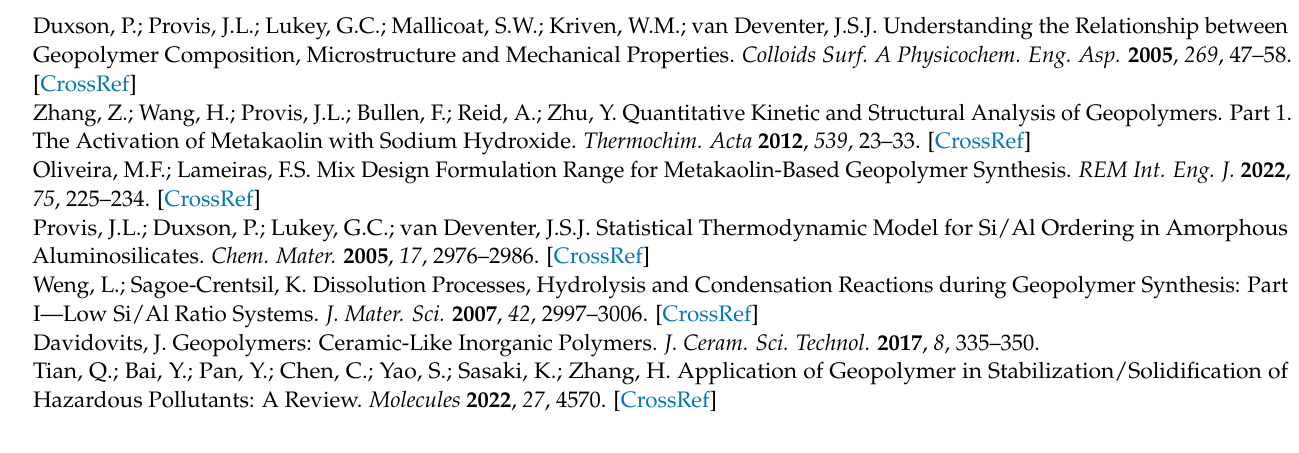
(B) GPA at different ageing times; Figure S2: IC measurements of (A) GP and (B) GPA at different ageing times; Figure S3: Geopolymer samples after the integrity test; Figure S4: Weight loss results of the geopolymer samples at different ageing times; Figure S5: Calibration curve of AO in water; Table S1: Results of the integrity